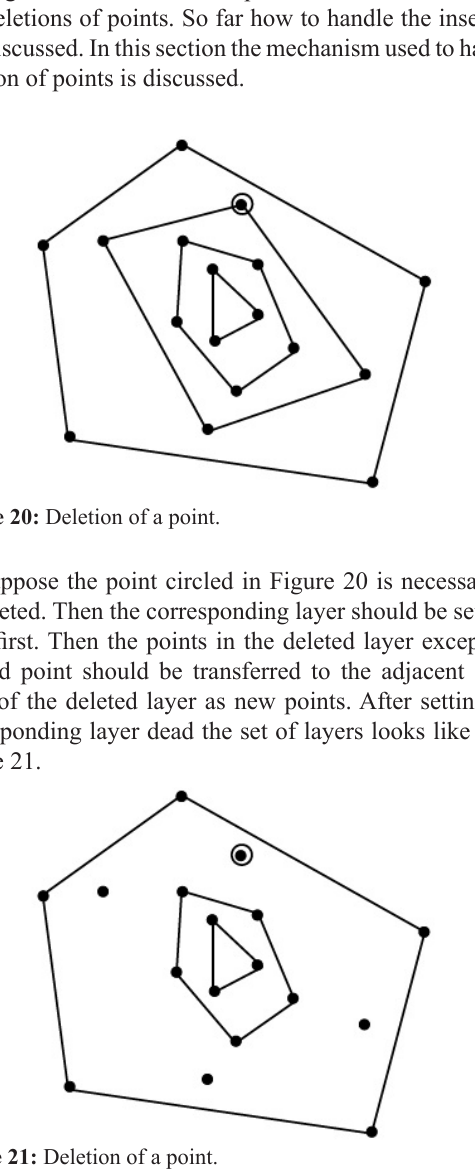
Figure 18: Duplicate edges are dead.